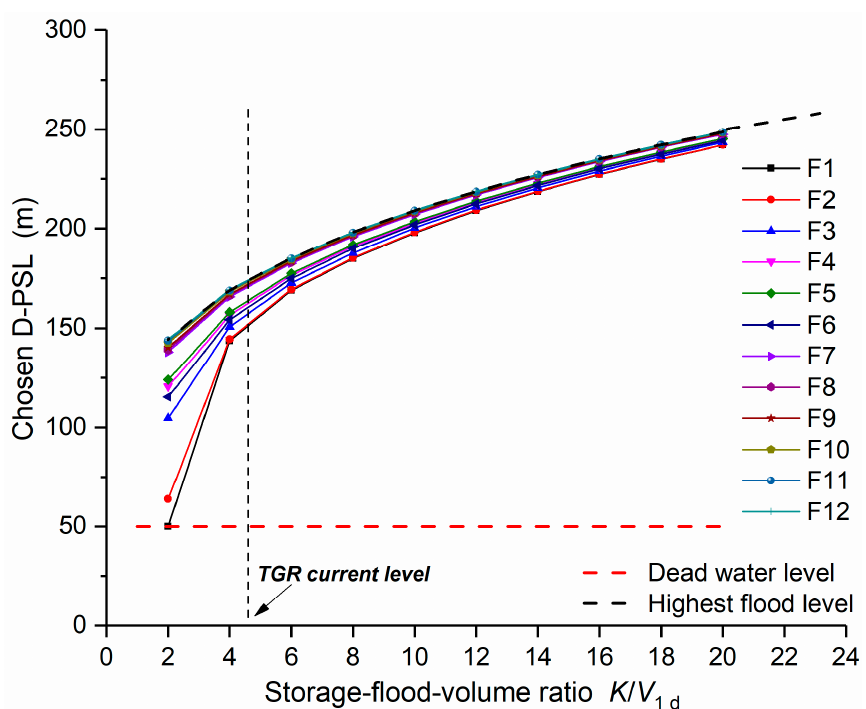
Figure 9. The relationship between chosen D-PSL and reservoir capacity–flood-volume ratio ( K / V 1 d ) for 12 selected forecast floods under moderate forecast skill ( C p = 0.5), the vertical dashed line represents the current TGR capacity–flood-volume ratio.